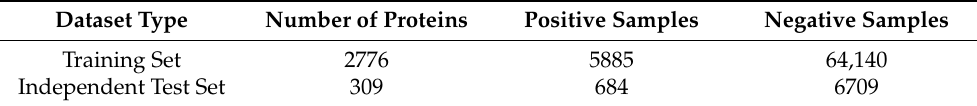
Table 1. Number of positive and negative samples for training set and independent test